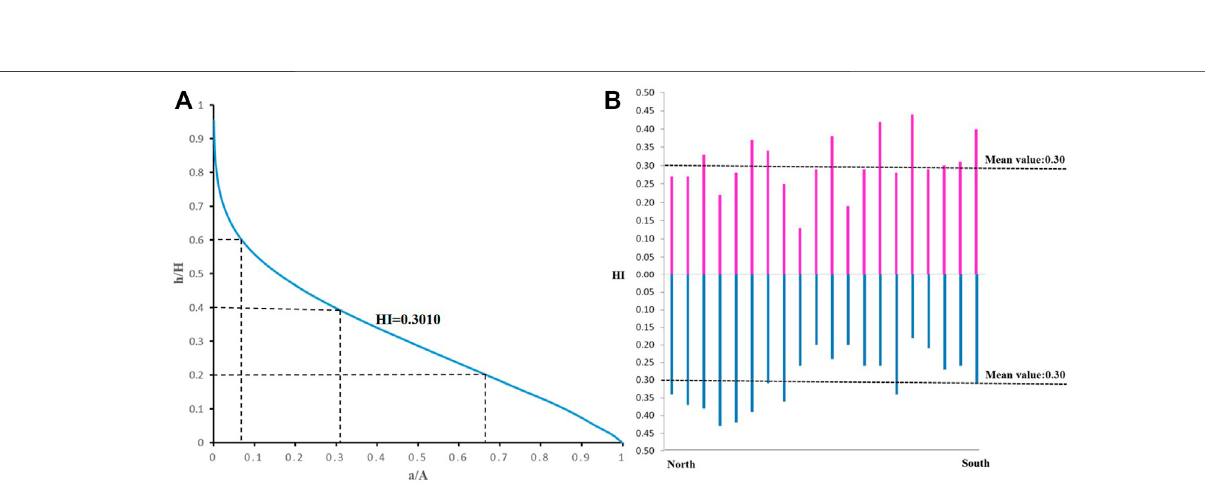
Frontiers in Earth Science |